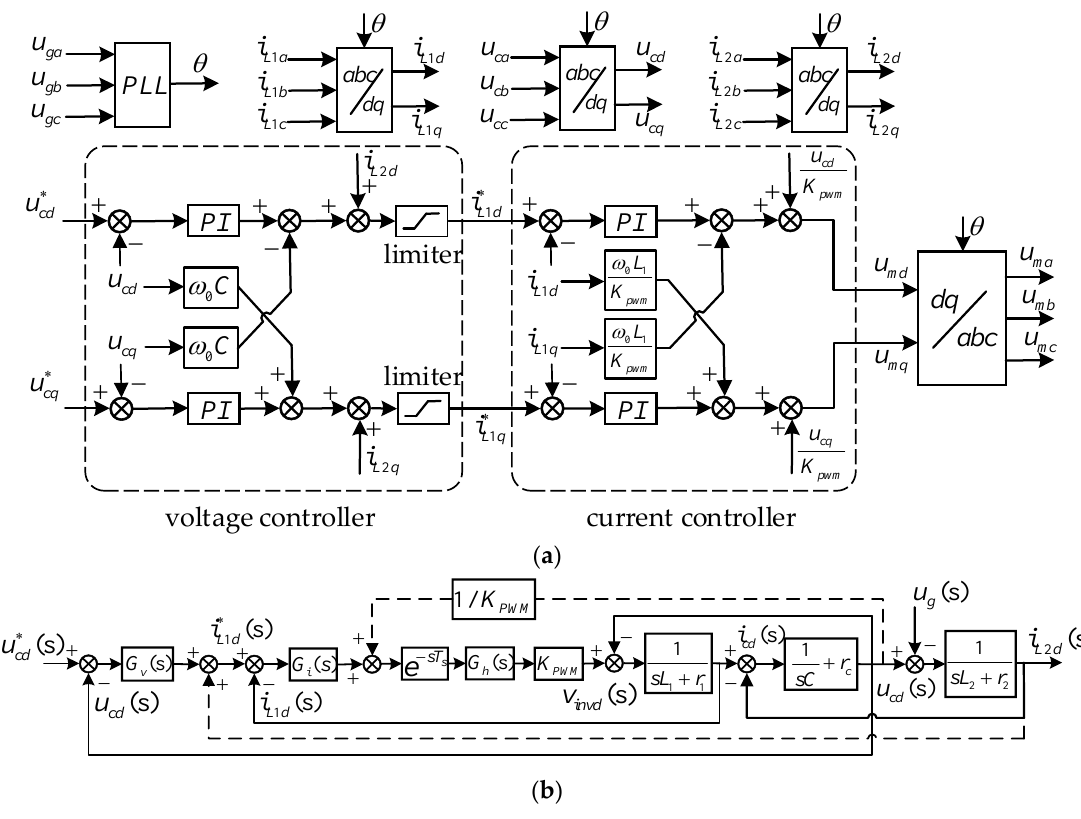
Figure 2. Schematic diagram and model of the control part: ( a ) Schematic diagram of the voltage and current controllers; ( b ) Control block diagram of the voltage and current loops in d -axis.